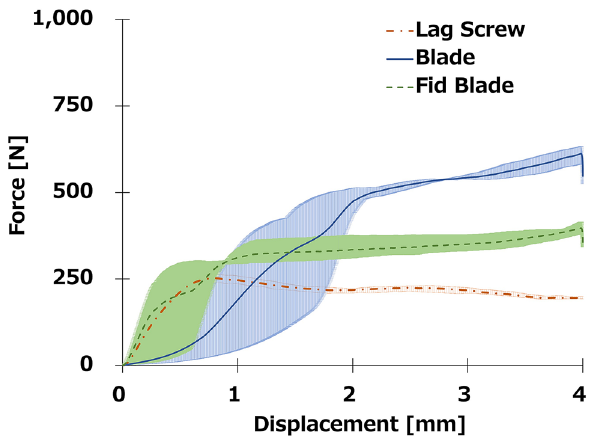
Figure 5. Mean force–displacement curves for the push-in test for a density of 0.08 g/cm 3 . The